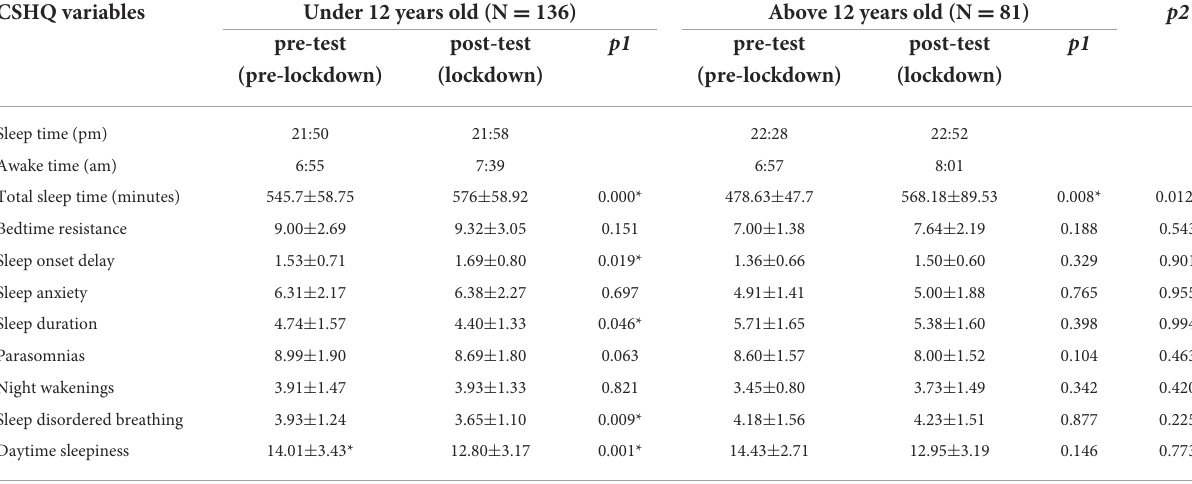
TABLE 1C Comparison of CSHQ of different age groups during the lockdown and pre-lockdown periods. CSHQ variables